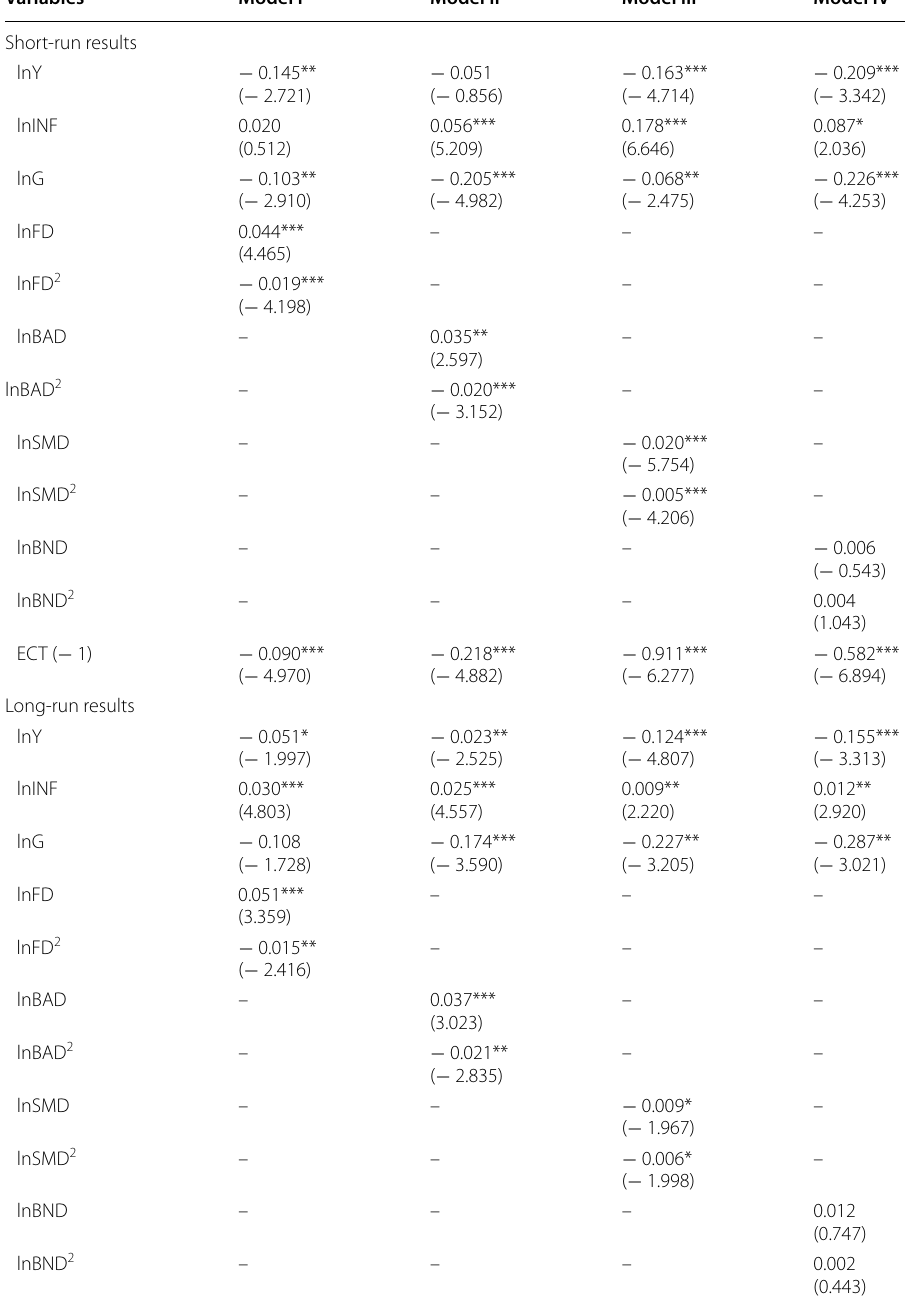
*, **, and *** indicates statistical significance at 10, 5, and 1% level, respectively. Numbers in parentheses are t -statistics. The coefficients of lagged variables are not shown for short-run results